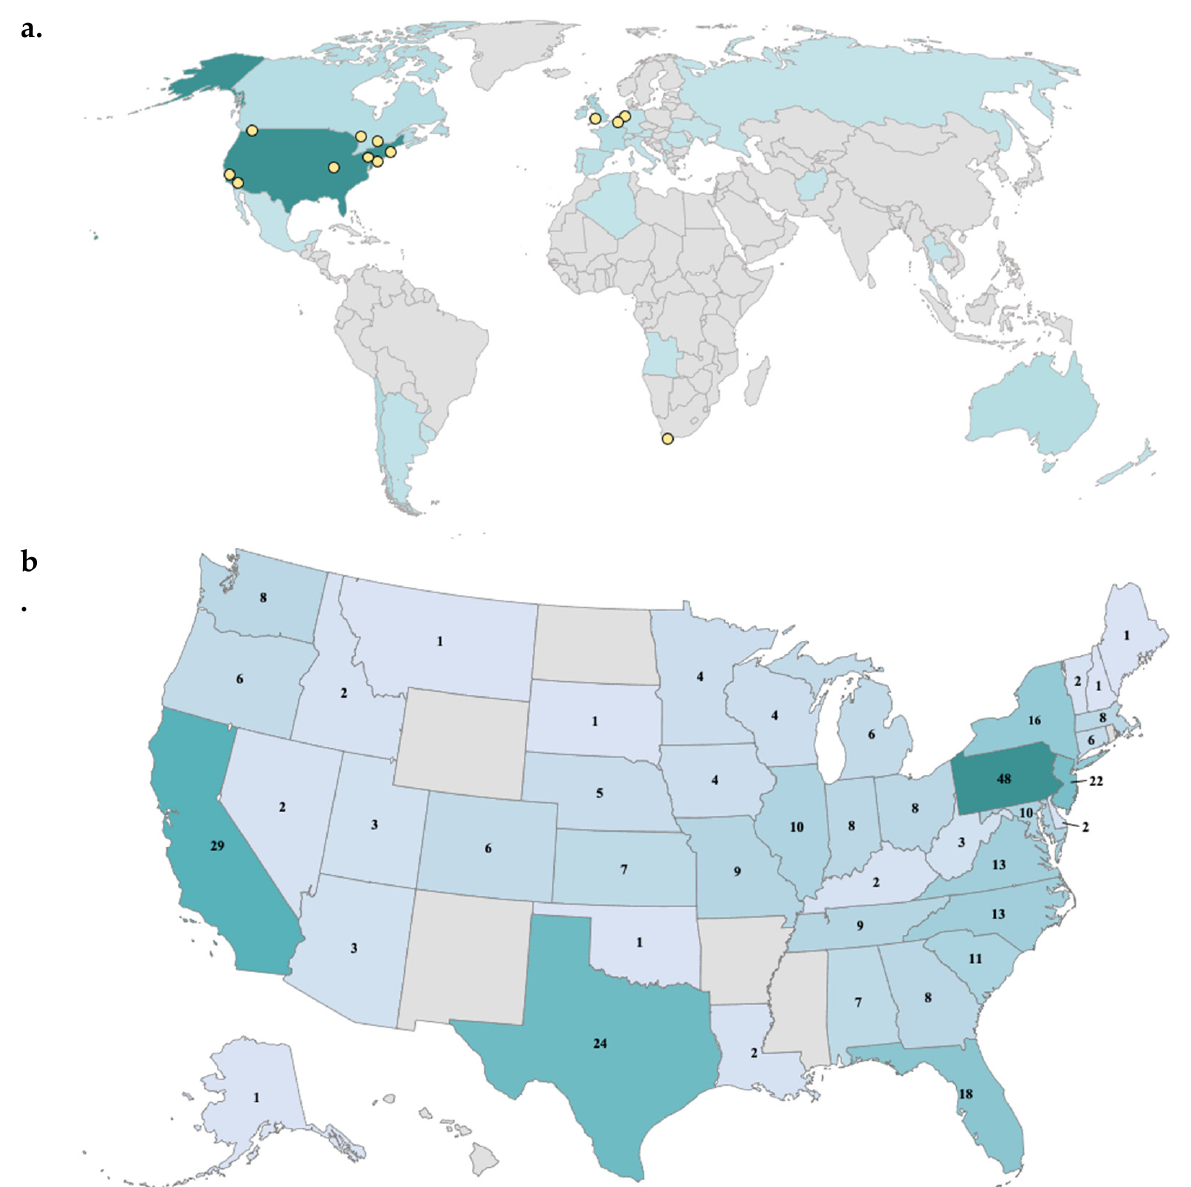
Figure 2. Global Stakeholder Survey Responses and Genes to Mental Health Network Locations. Notes . Panel A shows responses by country. A total of 29 unique countries were represented in the survey responses. Over half of all survey responses originated from the United States (N = 358, 51%). The next eight highest ‐ responding countries combined to account for over a quarter (28%) of the total sample: United Kingdom (N = 54), Chile (N = 35), Australia (N = 25), Canada (N = 24), Belgium (N = 24), France (N = 23), Ireland (N = 21), and Spain (N = 14). In total, 12% of all respondents de ‐ clined to answer. Panel B shows responses within the United States. Responses were recorded in 44 states, with a slight concentration in the Mid ‐ Atlantic and Northeast regions. The five states with member institutions in the G2MH Network accounted for 29% of the US sample: Pennsylvania (N = 48), California (N = 29), Missouri (N = 9), Washington, and Massachusetts (both N = 8).